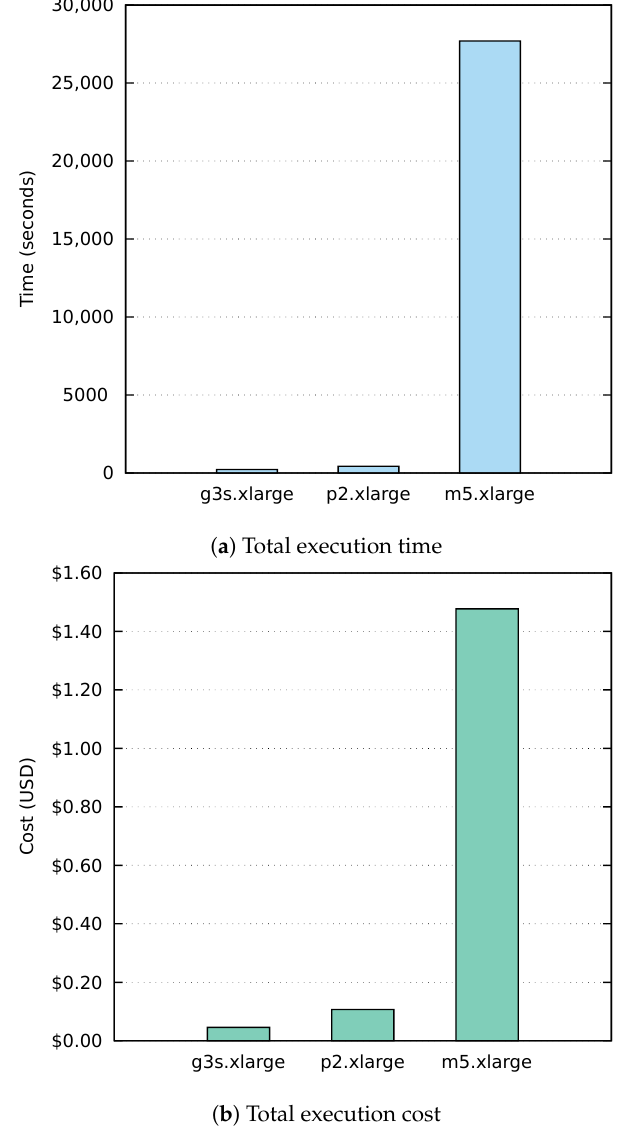
Figure 6. Comparison between CPU and GPU instances for video object